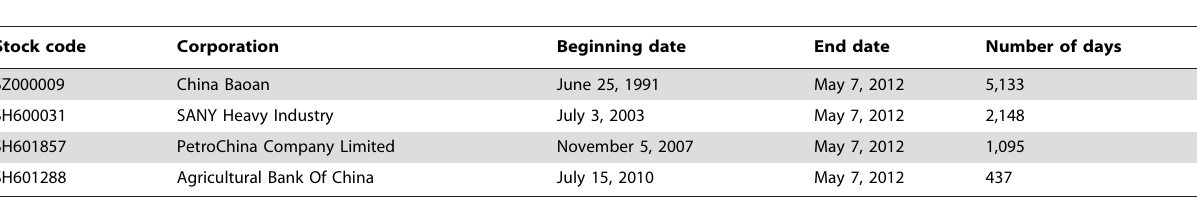
Table 2. Samples of the analyzed database of the Shanghai Shenzhen CSI 300 index stocks.